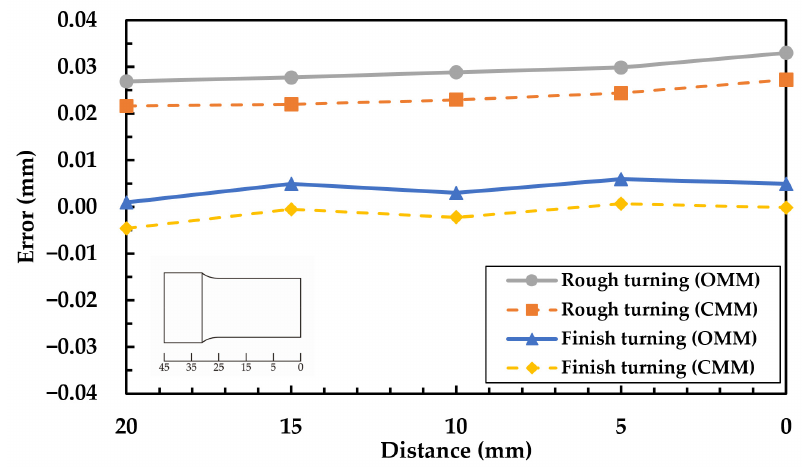
Figure 10. Machining errors along the length of the workpiece in turning machining.